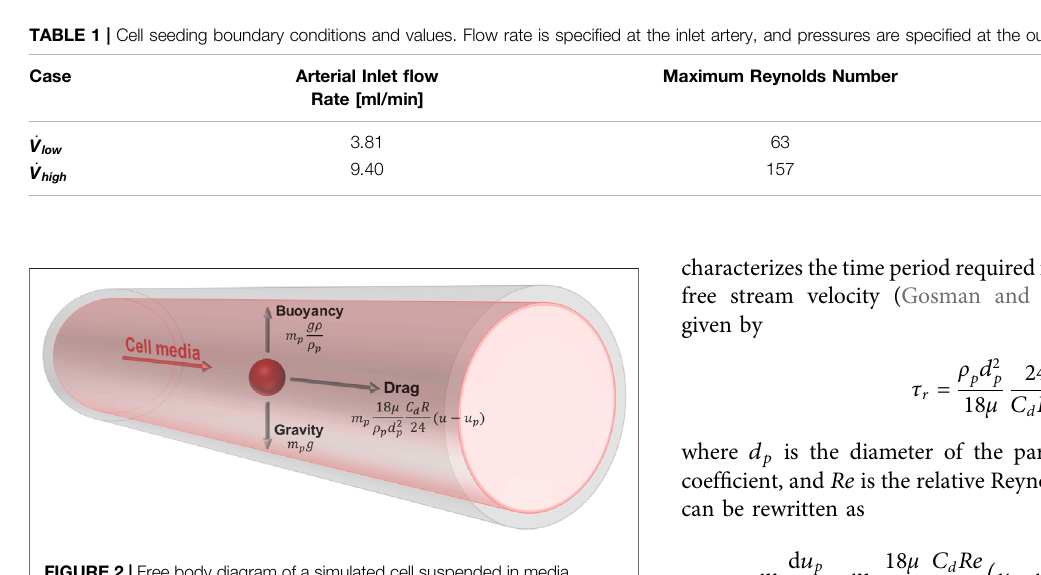
FIGURE 2 | Free body diagram of a simulated cell suspended in media within the vessel. The cell has a density of 1,050 kg/m 3 and diameter of 15 μ m. The media has a density of 1,000 kg/m 3 and viscosity of 0.94 cP. The trajectory of the particle is in fl uenced by drag forces from the surrounding fl uid, buoyancy, and gravity.